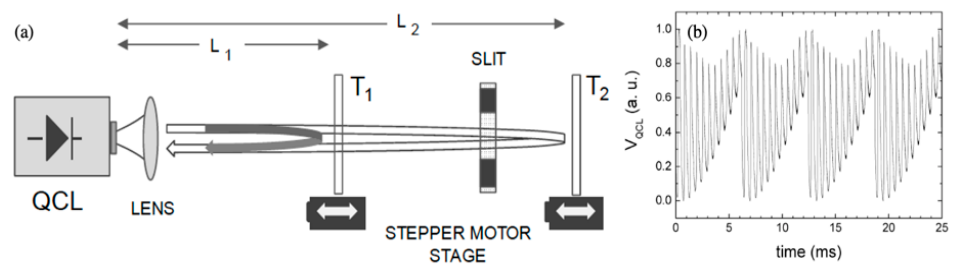
Figure 7. ( a ) Schematic setup illustrating the self-referenced OF principle. T 1 is a semitransparent reference target sets in motion whose partial reflection modulates the OF signal from target T 2 , as shown in ( b ). The slit between T 1 and T 2 sets the relative feedback strength κ 1 / κ 2 (adapted from Reference [39]).